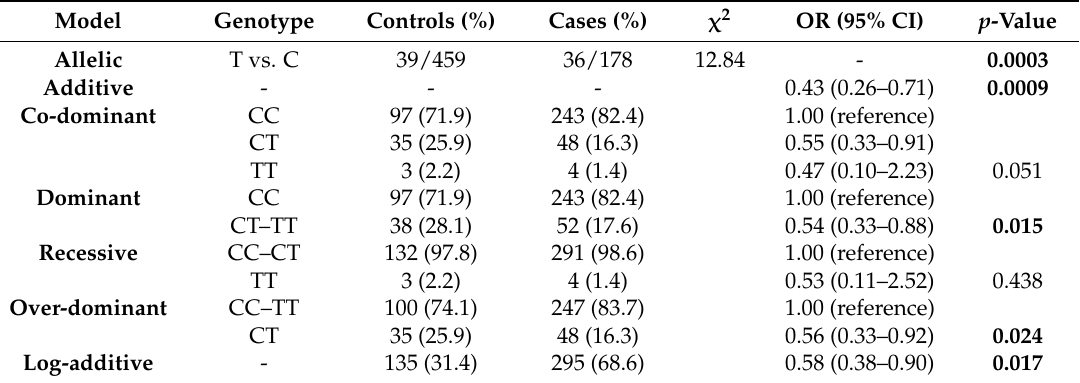
Table 6. Mixed model logistic regression analysis adjusted for the covariate ‘sex’ for the rs17723799 SNP in MIR143 .